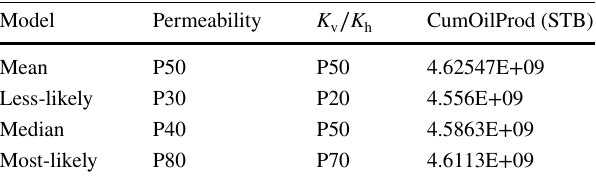
Table 1 Quantiles of parameters in the geological uncertainty